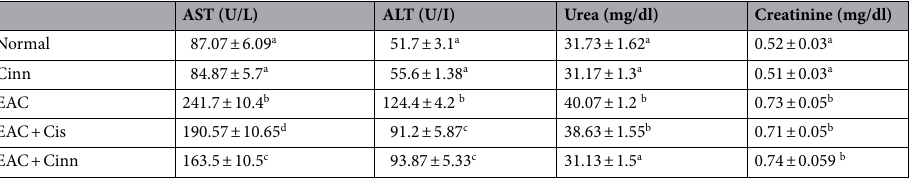
Table 5. The effect of Cinn treatment on the biochemical parameters in EAC-bearing mice. Data were shown as mean ± SD, ( n = 3). Significant differences ( P < 0.05) between groups were shown by different letters. EAC, Ehrlich ascites carcinoma; Cis, Cisplatin (2 mg/kg b.wt, i.p); Cinn, Cinnamon essential oil (50 mg/kg b.wt/day, orally); AST, Aspartate aminotransferase; ALT, Alanine